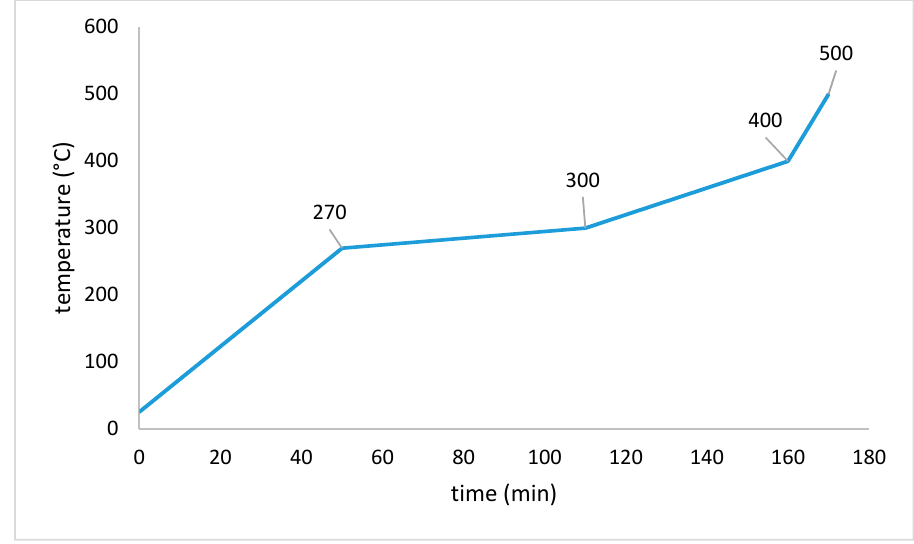
Figure 6. Debinding program E-MP/9 .